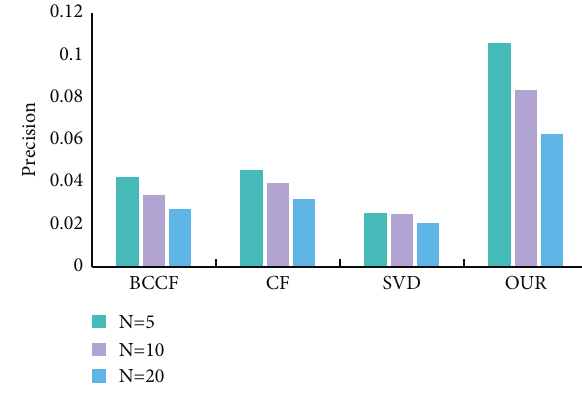
Figure 3: Comparison of precision on MovieLens latest.